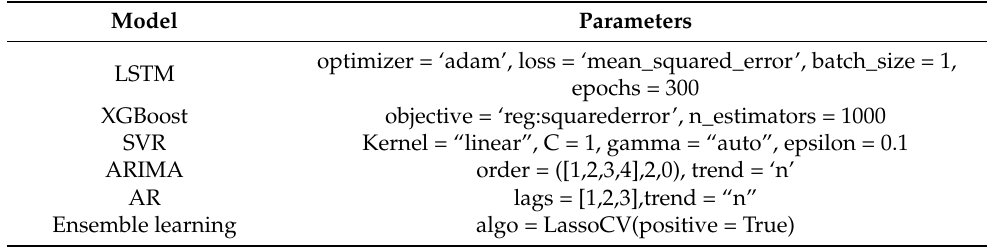
Table A1. The parameters used for the